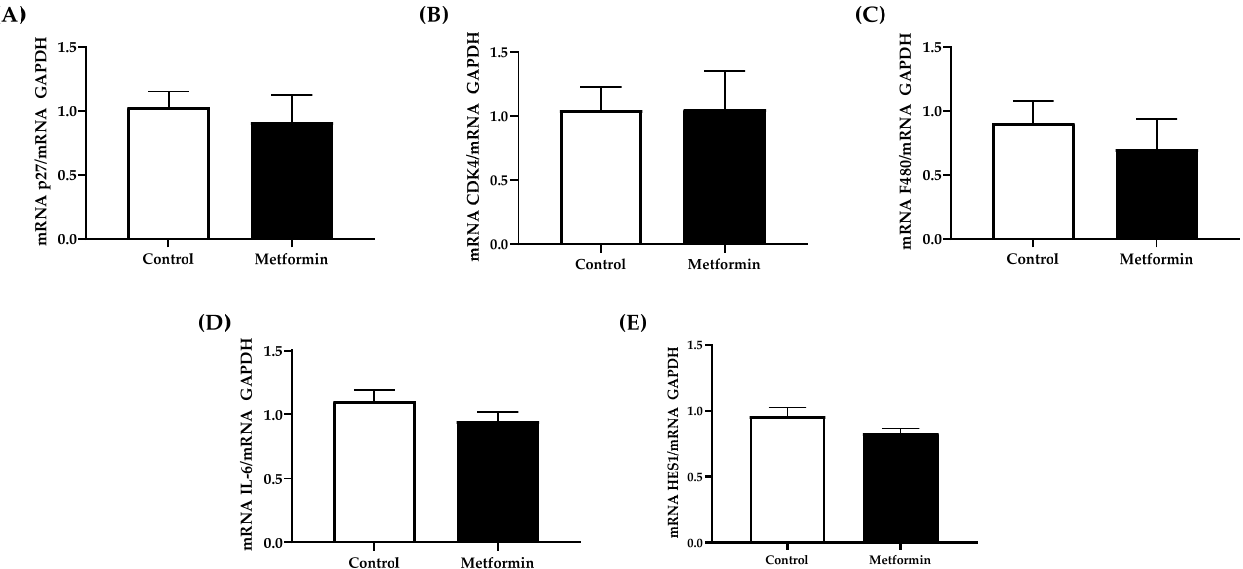
Figure 6. Gene expression in tumor mass collected from C57BL/6J male and female mice following orthotopic LL/2 non-small lung cancer cell implantation. ( A ) mRNA cyclin-dependent kinase inhibitor (p27)/GAPDH; ( B ) mRNA cyclin-dependent kinase (CDK4)/GAPDH; ( C ) mRNA F480/GAPDH; ( D ) mRNA interleukin-6/GAPDH; ( E ) mRNA hairy and enhancer of split 1 (Hes1)/GAPDH. Tumor mRNA expression from C57BL/6J mice with NSCLC concomitant with or without metformin (250 mg/kg) treatment. Data were analyzed using an unpaired t -test. Sample size: Control, n = 6; metformin, n = 6. Data shown as mean ± SEM.